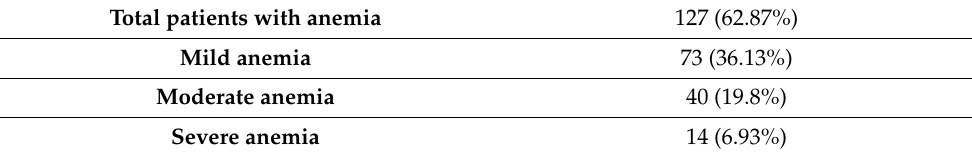
Table 2. Patients with